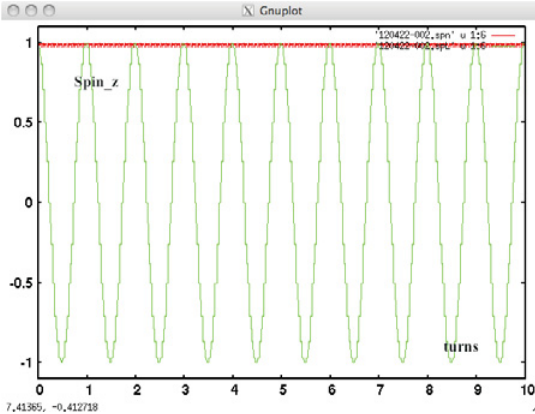
Figure 7. Longit. component of the frozen spin: red line in accelerator coordinates, green line, in laboratory coordinates. The red line shows little wiggles because the responsible proton is on purpose not perfectly magic and there are energy